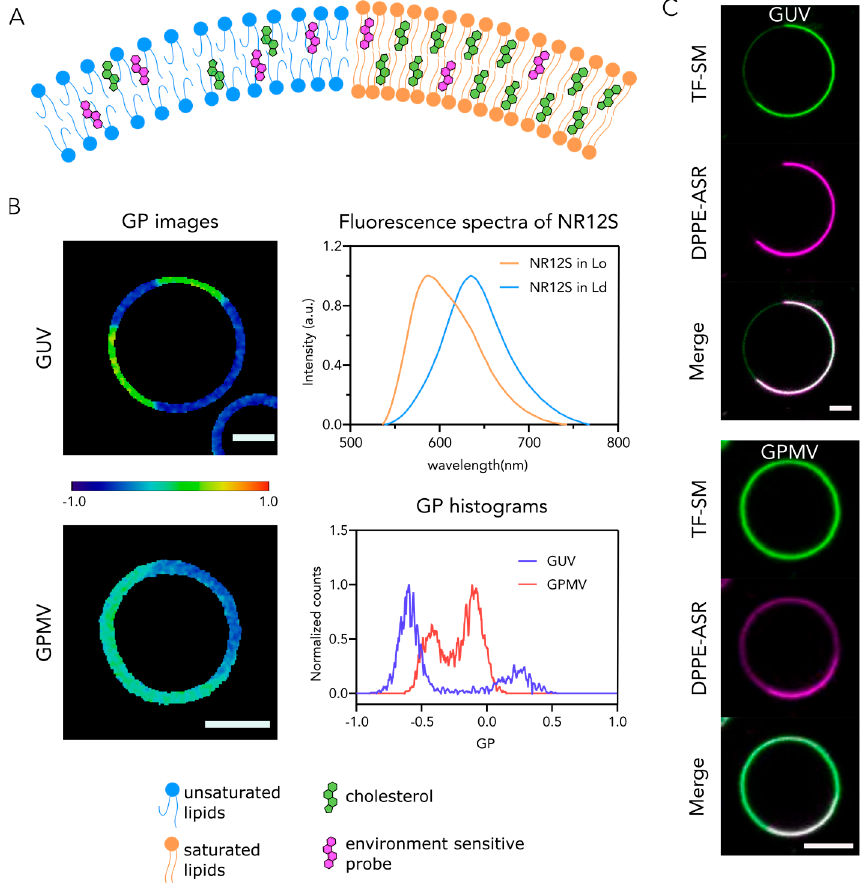
Figure 2. Membrane order in Lo and Ld phases of synthetic (GUVs) and cell ‐ derived (GPMVs) membranes: ( A , B ) Visualization of phase separation in synthetic and cell ‐ derived membrane systems using phase sensitive probes; ( A ) Cartoon of phase separation and distribution of phase ‐ sensitive probes; ( B ) Ratiometric imaging of phase separation in GUVs and GPMVs using the environmental-sensitive probe NR12S. Fluorescence spectrum of NR12S exhibits a drastic red shift in Ld in comparison to Lo. The images of membranes at 560 nm and 650 nm emission wavelengths were recorded and used to produce GP images. The color code on the GP images corresponds to the color bar: dark red is +1, and dark blue is − 1. The GP histograms for both GUV and GPMV show two distinct populations. In each case, low GP counts correspond to Ld whereas high GP counts correspond to Lo. Importantly, GP values of Ld and Lo are different for GUVs and GPMVs. ( C ) TopFluor ‐ labeled SM (TF ‐ SM, green) partitions into Ld in GUVs (DOPC:SM:Chol, 2:2:1) while it partitions to both phases in GPMVs derived from U2OS cells. The DPPE ‐ Abberior Star Red (DPPE, ASR, magenta) partitions preferentially to Ld in both GUVs and GPMVs. Scale bars are 5 μ m.